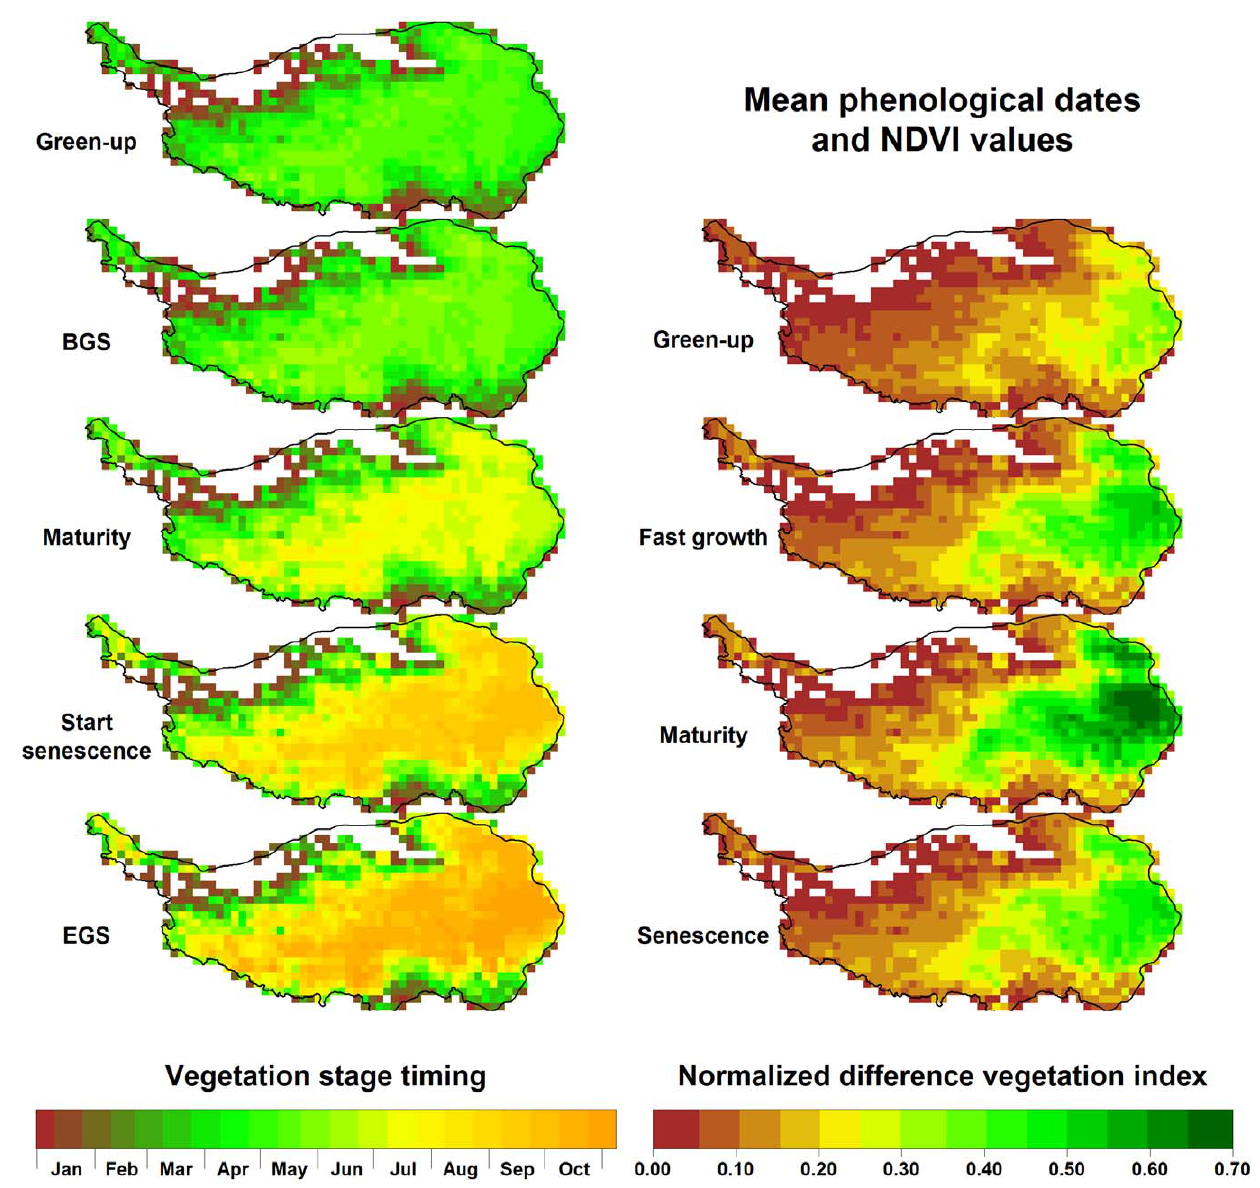
Figure 3. Mean phenological dates and vegetation activity during different growth stages on the Tibetan Plateau, based on NDVI data between 1982 and